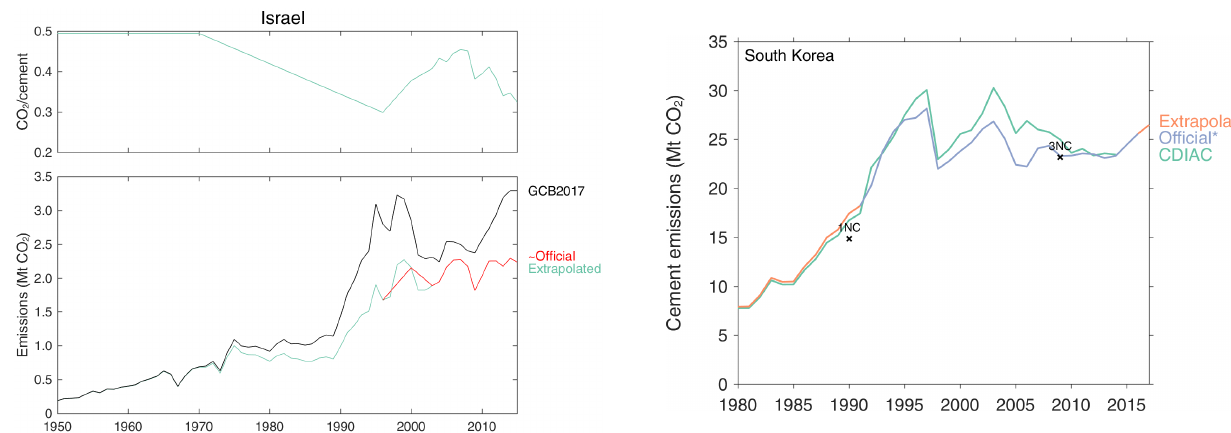
Figure C21. Revised cement emissions in Israel.